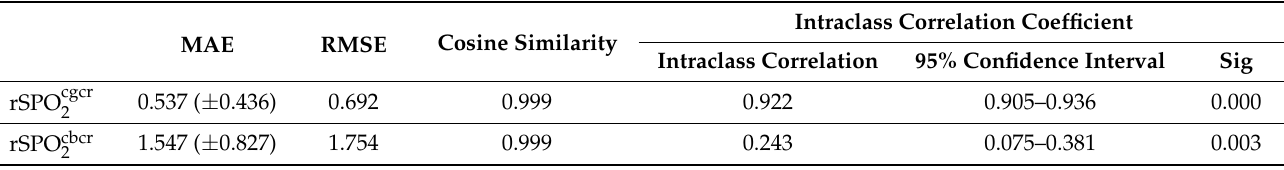
Figure 6. Comparison of rSPO 2 obtained by non-contact and reference SPO 2 obtained by contact sensor. The black line is the reference SPO 2 , the red line is the rSPO 2cgcr , and the blue line is the rSPO 2cbcr . Table 1. Statistical results of rSPO 2cgcr and rSPO 2cbcr . MAE = mean absolute error; RMSE = root mean squared error.